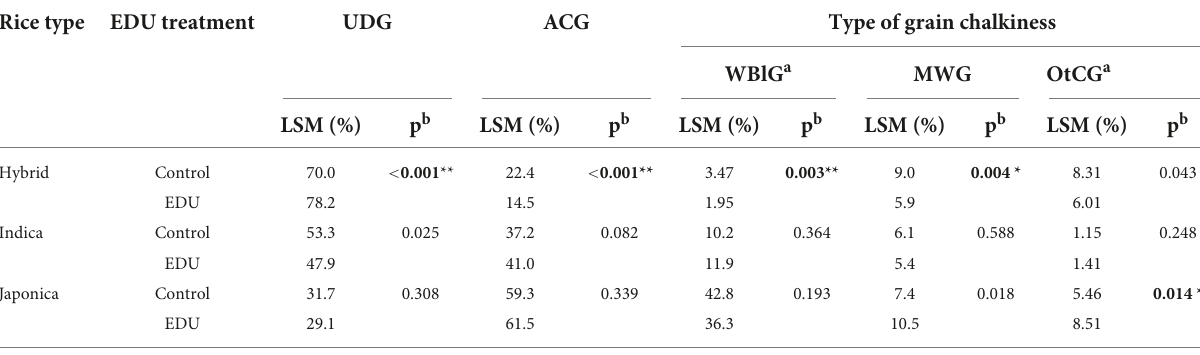
TABLE 2 Effects of EDU application on grain appearance traits in each rice type as shown by the least-square means (LSM) and p -values.